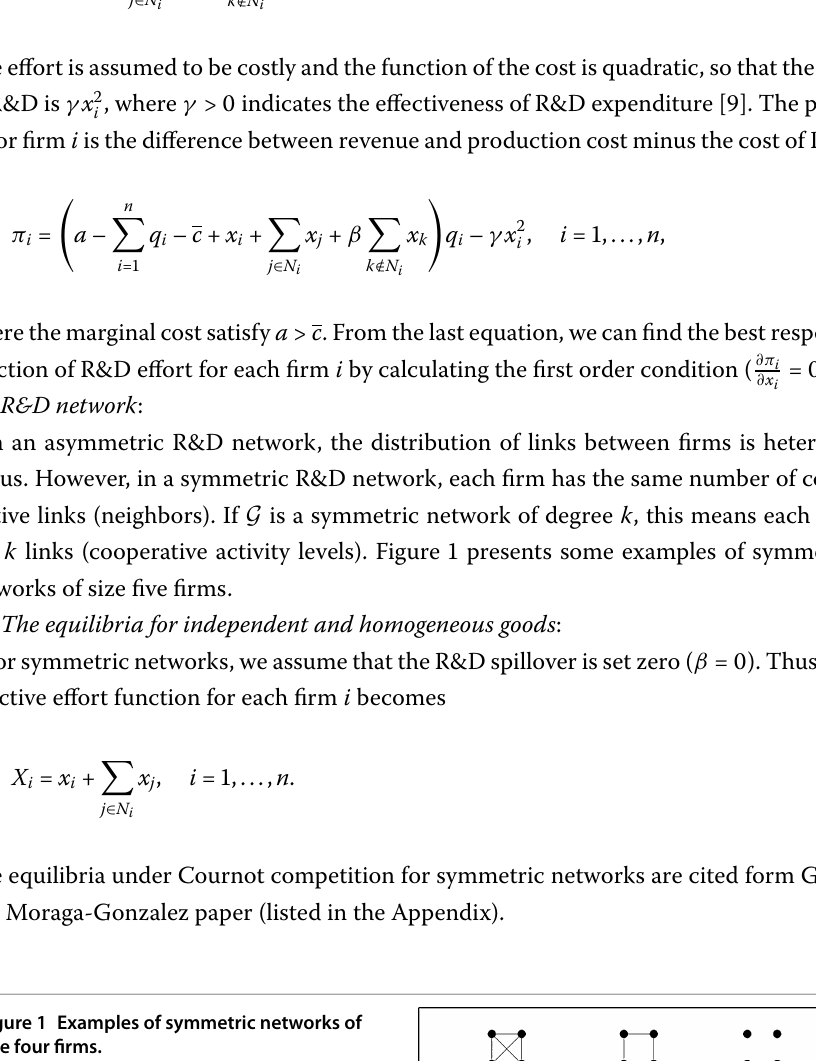
Figure 1 Examples of symmetric networks of size four